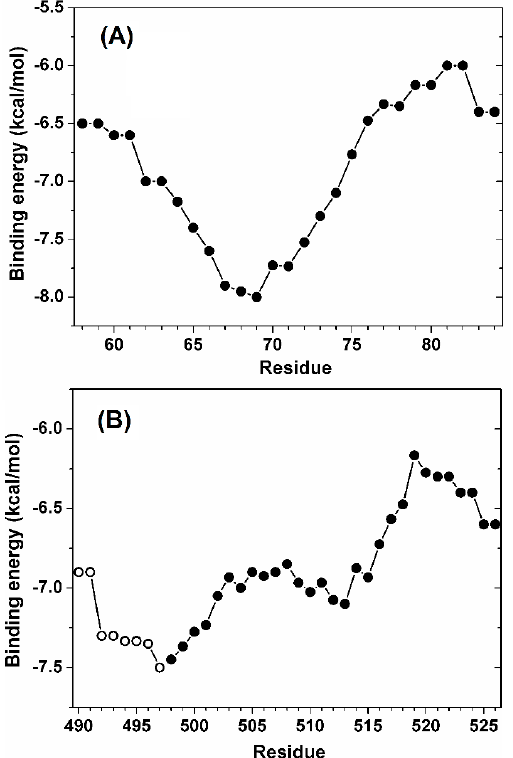
Figure 10. Affinity of the two NLS regions of PADI4 toward Imp α 3 estimated in molecular docking simulations. ( A ) Peptide NLS1-PADI4, encompassing residues 58–84. ( B ) The second NLS2 region of PADI4, including the N-terminal residues 490–497 (open symbols) and the peptide NLS2-PADI4 encompassing residues 498–526 (solid symbols). The affinity was calculated for seven-residue fragments, and values reported for each residue are the average over all simulation runs including that residue.